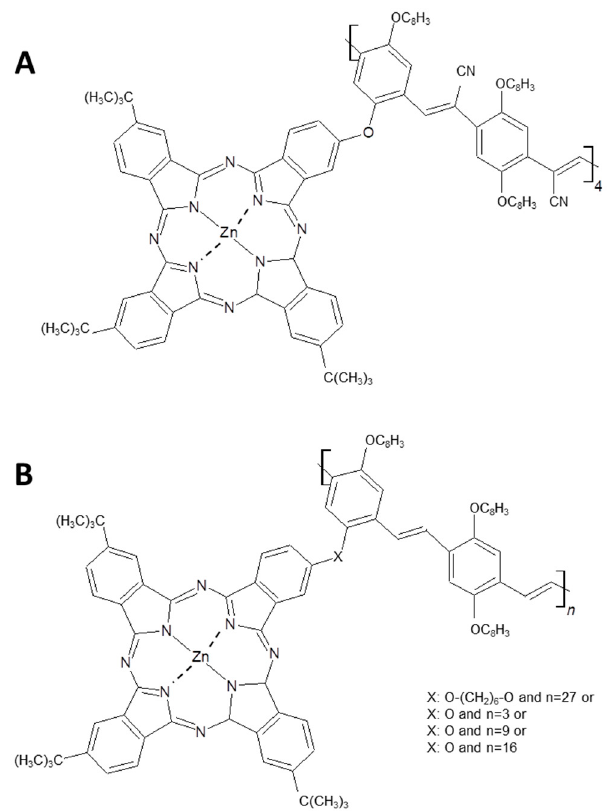
Figure 20. Six different ZnPcs chemical structures used to interact and to improve CNTs solubilization. ZnPc derivative ( A ) and ZnPc with X = O-(CH 2 ) 6 -O and n = 27, reported in ( B ), appear particularly efficient in the SWCNTs solubilization [114].